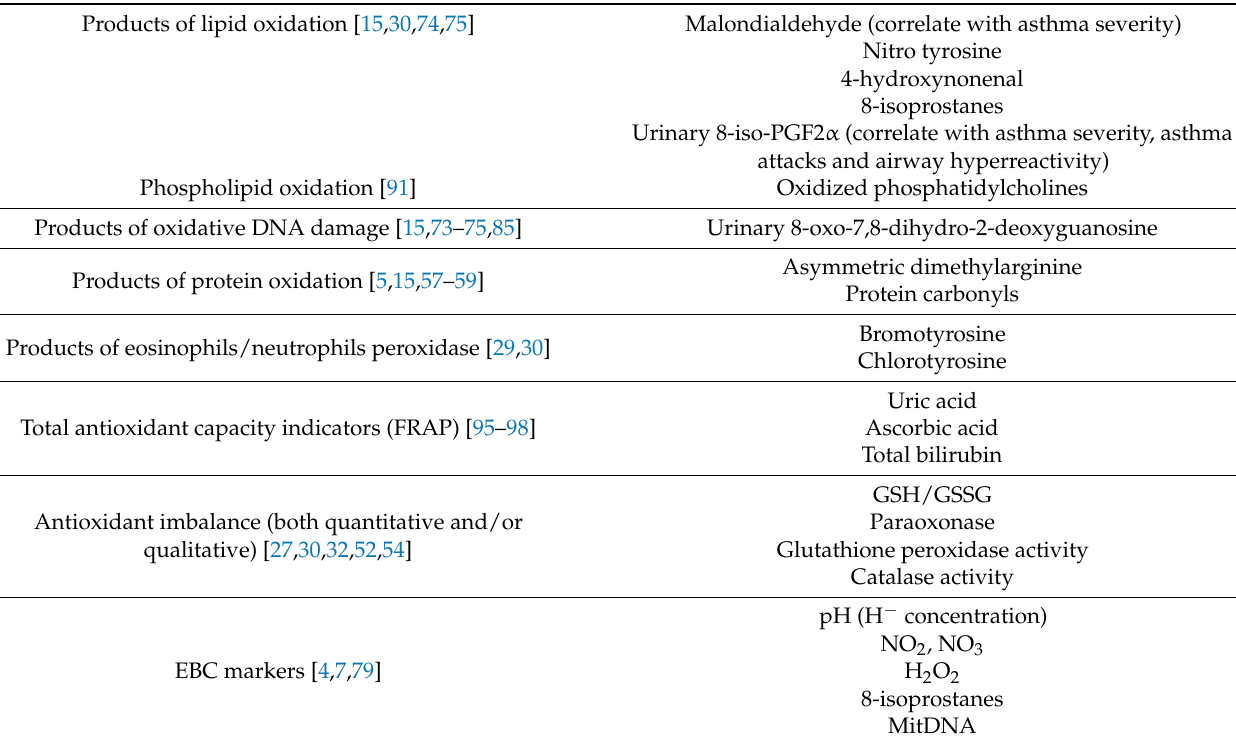
Table 1. Main indirect redox markers of asthma and severe asthma currently described in the